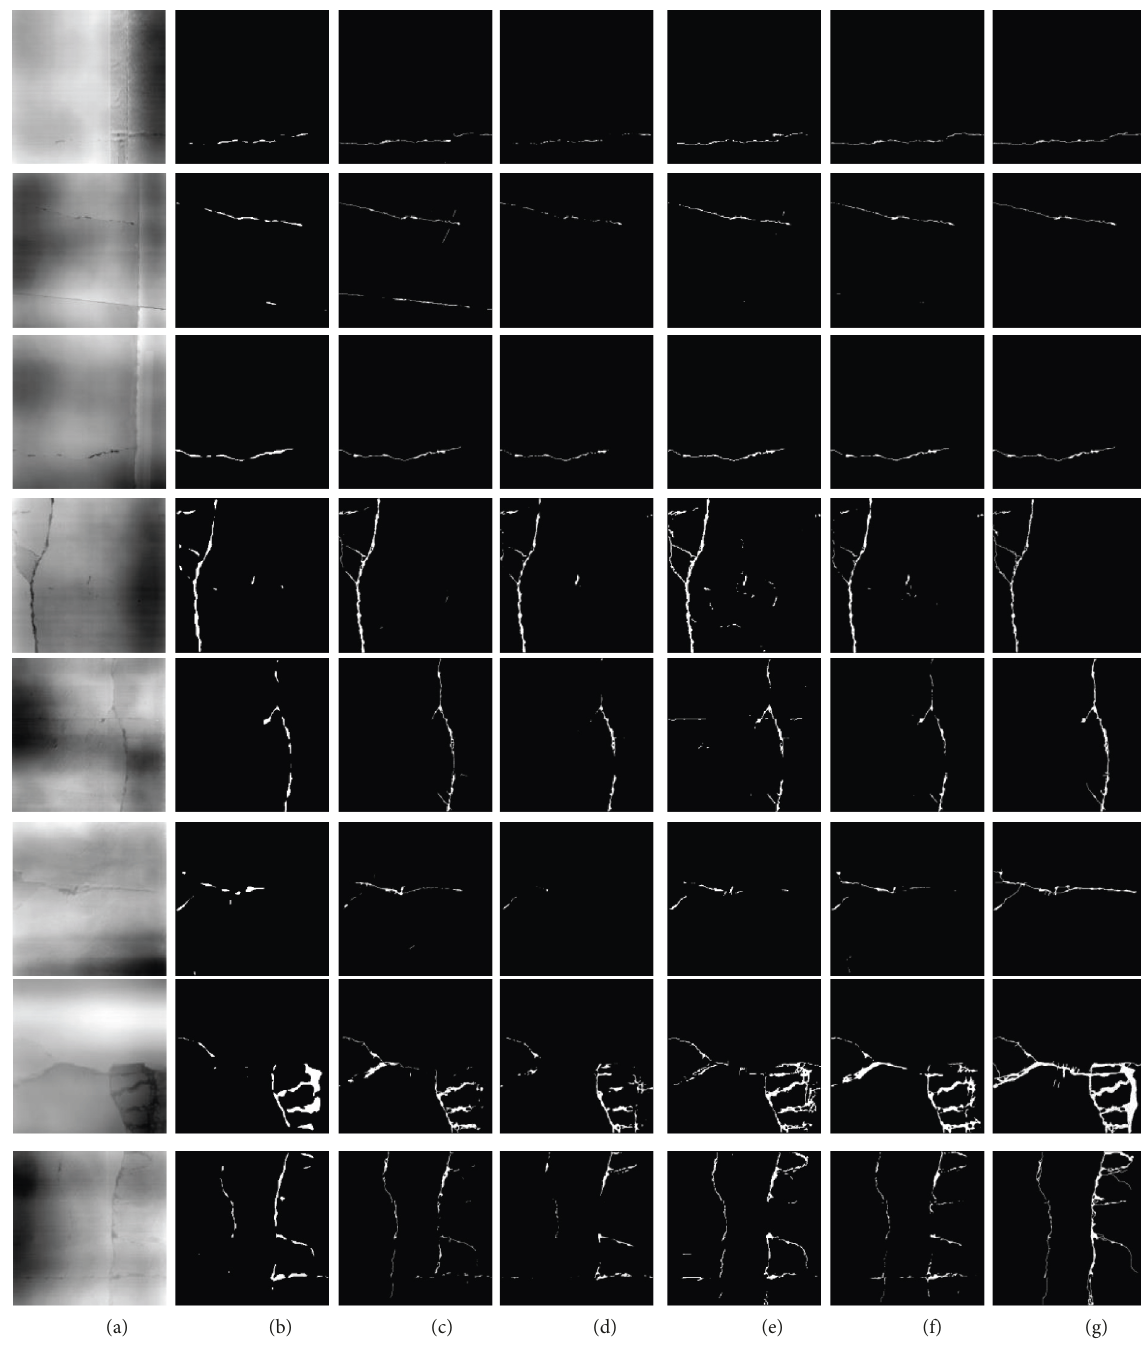
Figure 7: The segmentation results. (a) the original image, (b) the results of AutoEncoder, (c) the results of PSPNet, (d) the results of U-Net, (e) the results of KiU-net, (f) the results of GA-Unet, (g) ground truth of crack in pavement